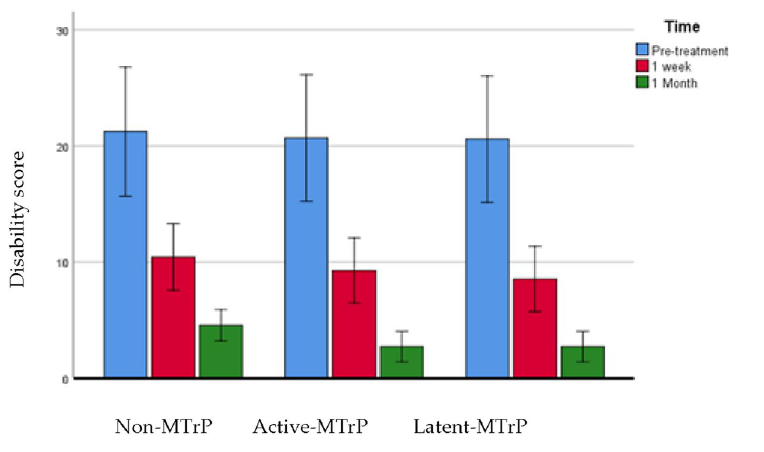
Figure 6. Neck Disability